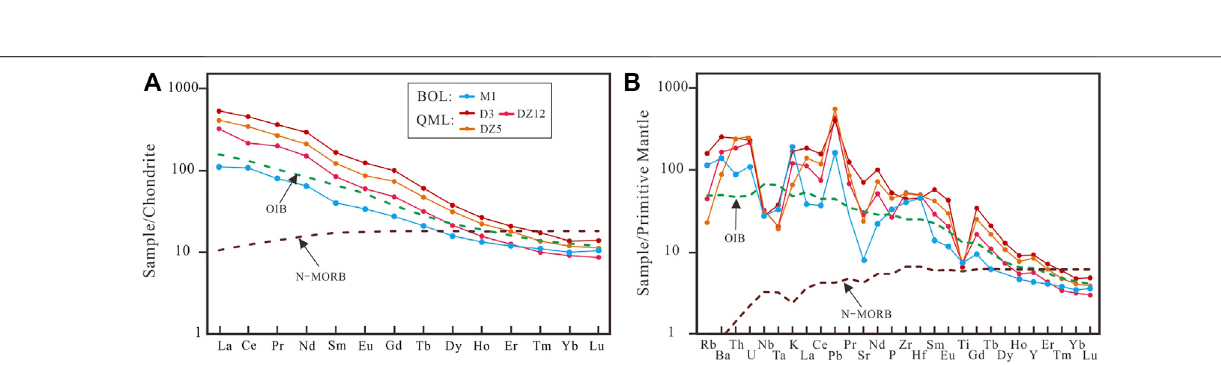
Frontiers in Earth Science |